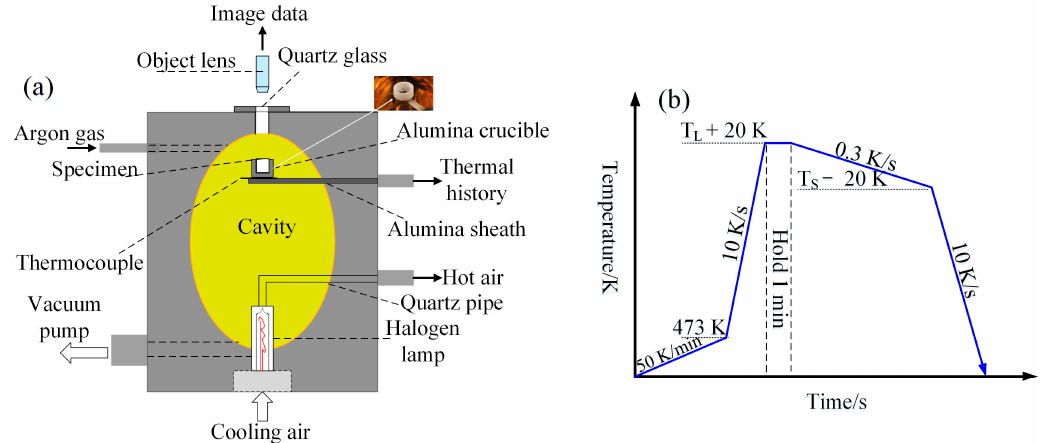
Figure 1. ( a ) Schematic diagram of laser scanning confocal microscope (LSCM); ( b ) the thermal